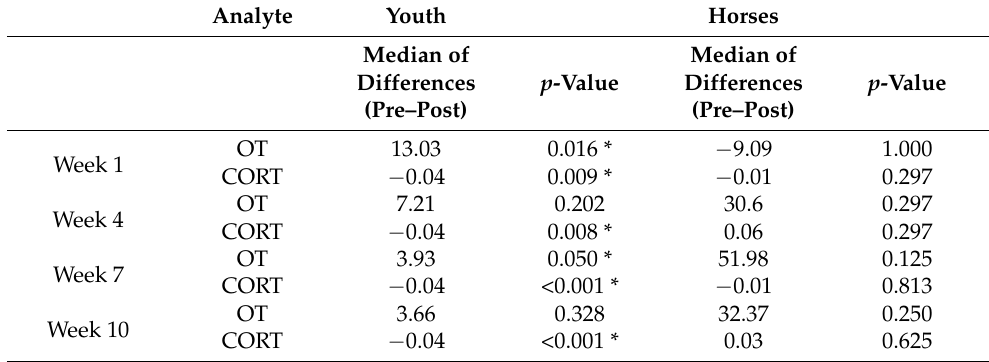
Table 1. Pre/post changes for oxytocin (OT) and cortisol (CORT) of youth and horses.